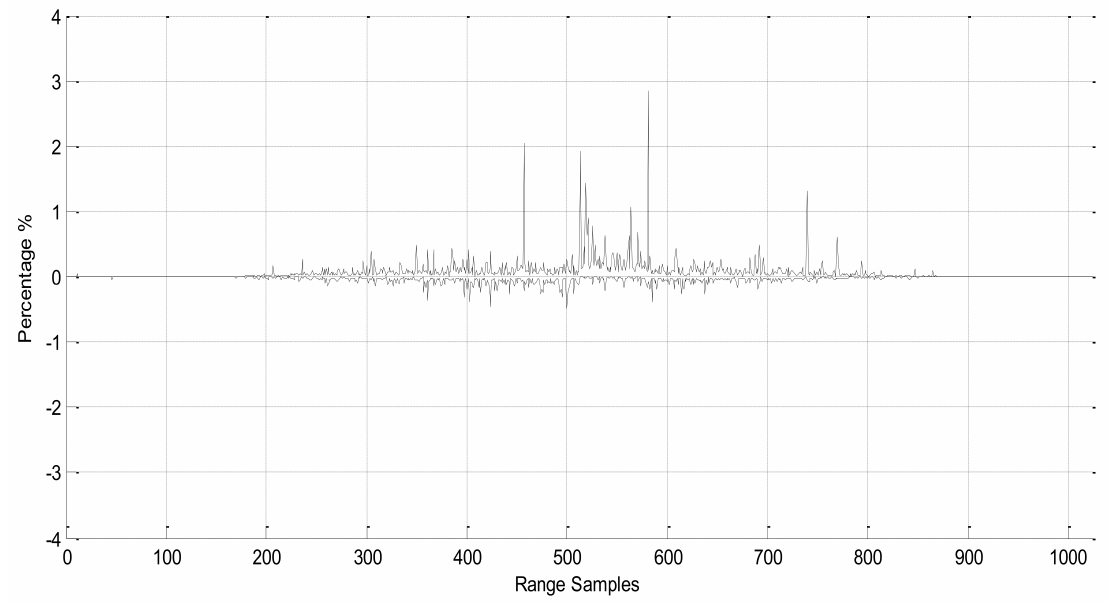
Figure 7. Difference in SAR raw data (range profile) in the frequency domain transformed by MATLAB and the proposed SAR